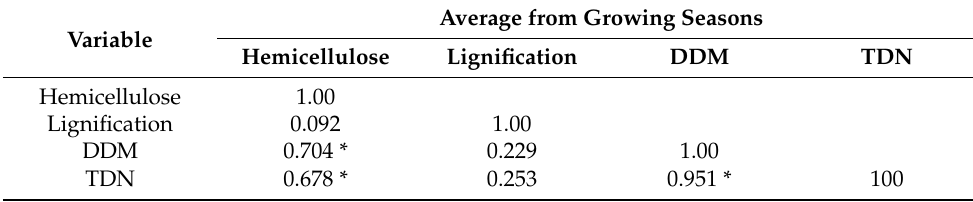
Table 8. Linear correlation coefficients between hemicellulose content, lignification rate, DDM, and TDN. Average from Growing Seasons Variable Hemicellulose Lignification DDM TDN Hemicellulose 1.00 Lignification 0.092 1.00 DDM 0.704 * 0.229 1.00 TDN 0.678 * 0.253 0.951 *